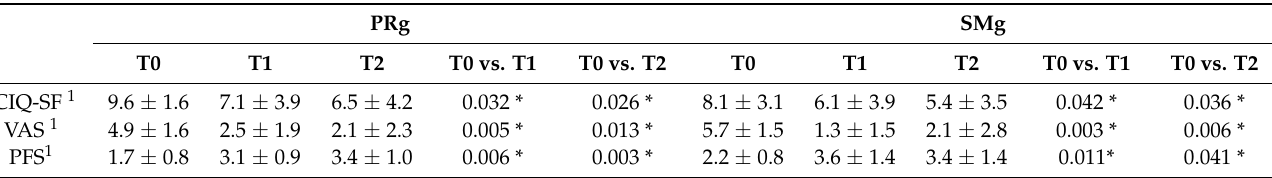
Table 3. Within-subject analysis